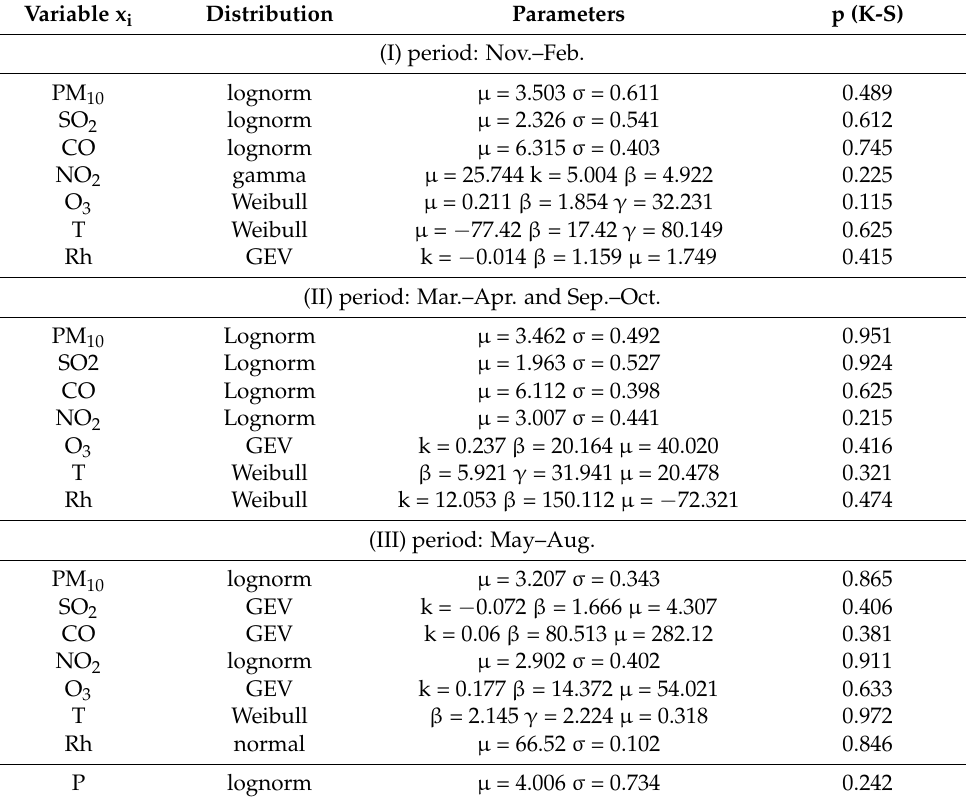
Table A2. Best fit theoretical distributions (according to Kolmogorov–Smirnov test) for the